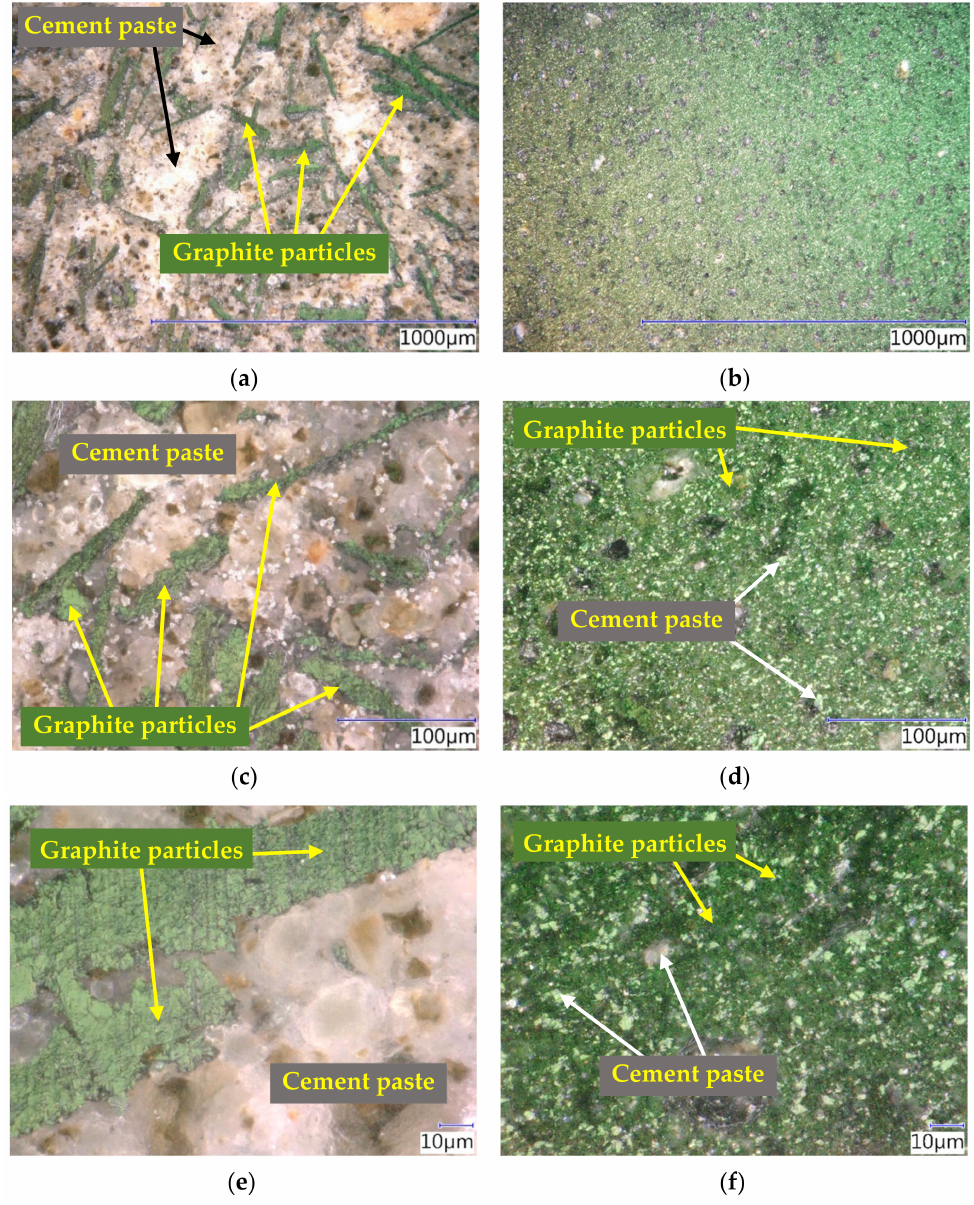
Figure 16. Images from the optical microscope: cement pastes with the graphite filler on the edge (Supragraphite C300—( a , c , e ); Condufit C4—( b , d , f )) upon 250 × magnification ( a , b ), 1000 × magnifi- cation ( c , d ), 2500 × magnification ( e , f